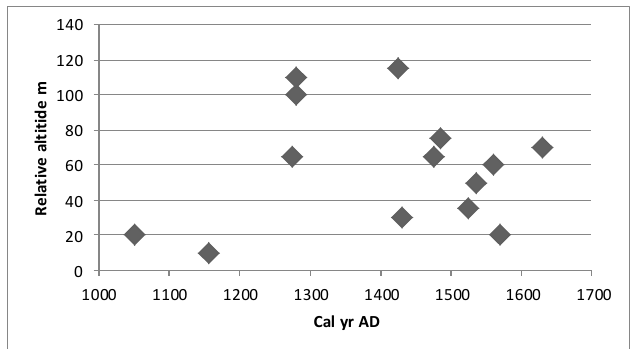
Figure 4: Radiocarbon-dates (intercept values) of all recovered pine megafossils and their relations to present- day altitude (m a.s.l.) of the pine treeline.